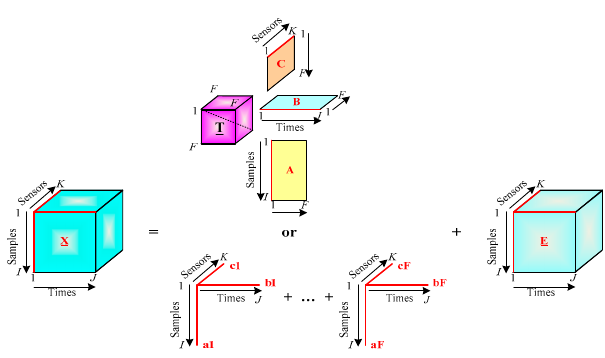
Figure 3. Graphical description of the PARAFAC model of X (samples × times × sensors).